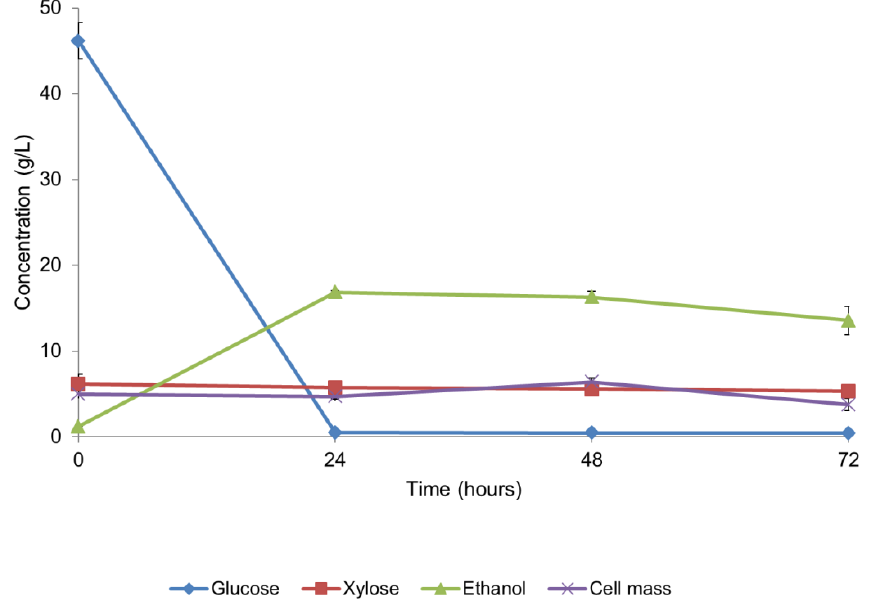
Figure 4. Profile of bioethanol production by S. cerevisiae on optimised enzymatic hydrolysate of BSG residue. Standard deviations are calculated from duplicates.